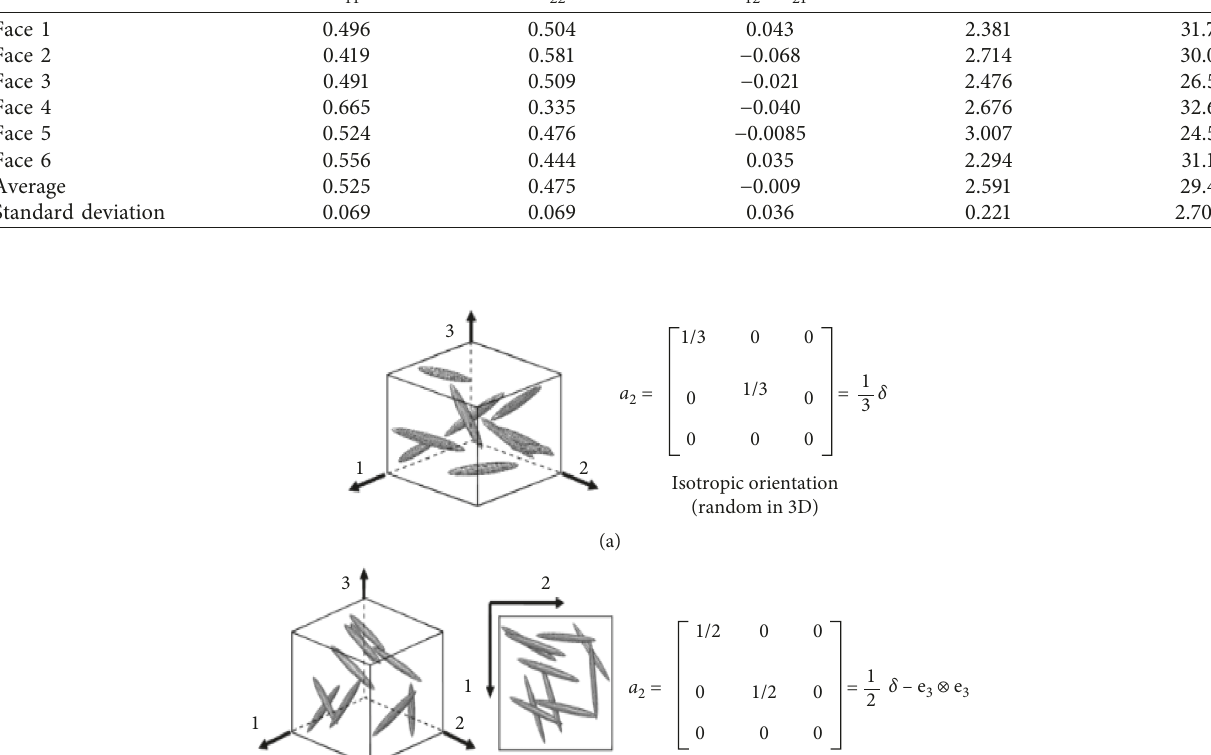
Components of the tensor a 2 a 11 a 22 a 12 � a 21